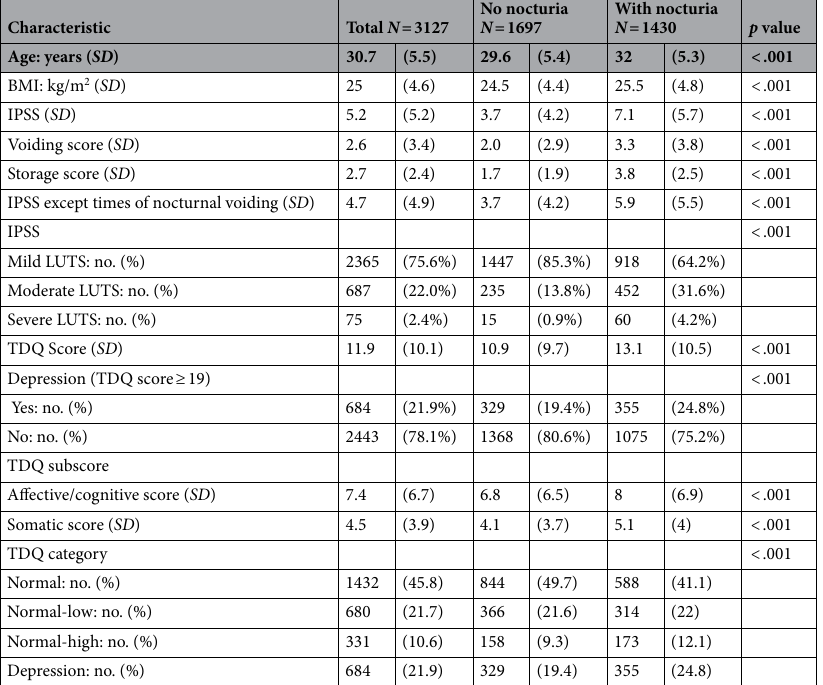
Table 1. Characteristics of total participants and participants with and without nocturia. BMI = body mass index; IPSS = International Prostate Symptoms Score; LUTS = lower urinary tract symptoms; TDQ = Taiwanese Depression Questionnaire.